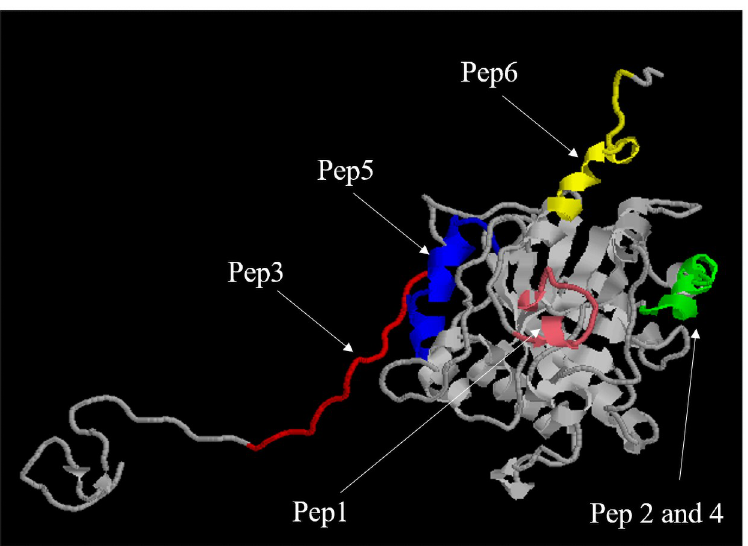
Fig 4. 3D model of CP40 looking at the immunodominant epitope local. Peptide 1—pink; Peptide 2 and 4—green; Peptide 3—red; Peptide 5—blue and Peptide 6—yellow. This 3D model was predicted by abnitio for Droppa-Almeida, Franceschi and Padilha (2018) [17], and used by Rasmol to look the local for each epitope.